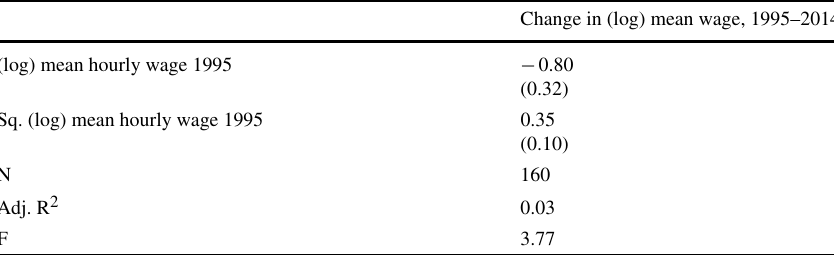
Table 3 OLS regression for wage polarisation analysis. Sources : author’s analysis from the Structure of Earnings Survey (1995 and 2014)